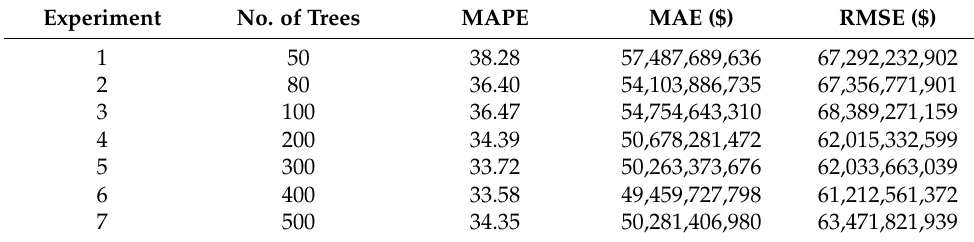
Table 4. Revenue loss prediction error of different experiments for the storm category.